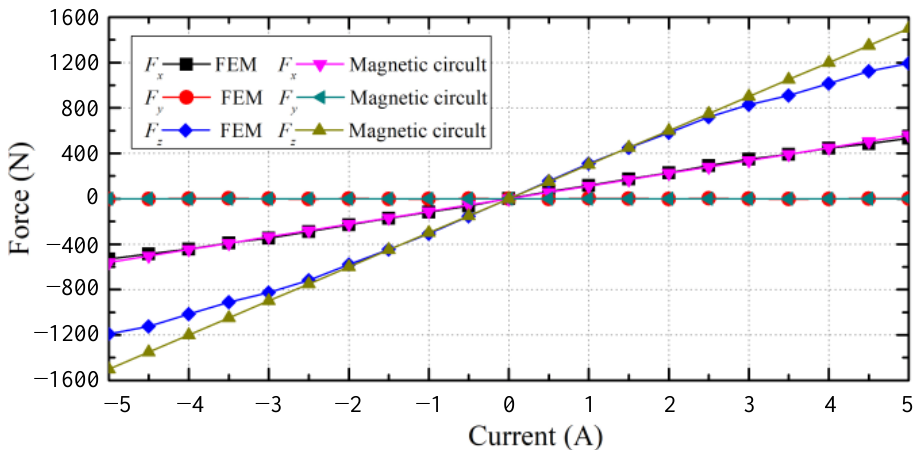
Figure 8. Variations in radial and axial force with current.